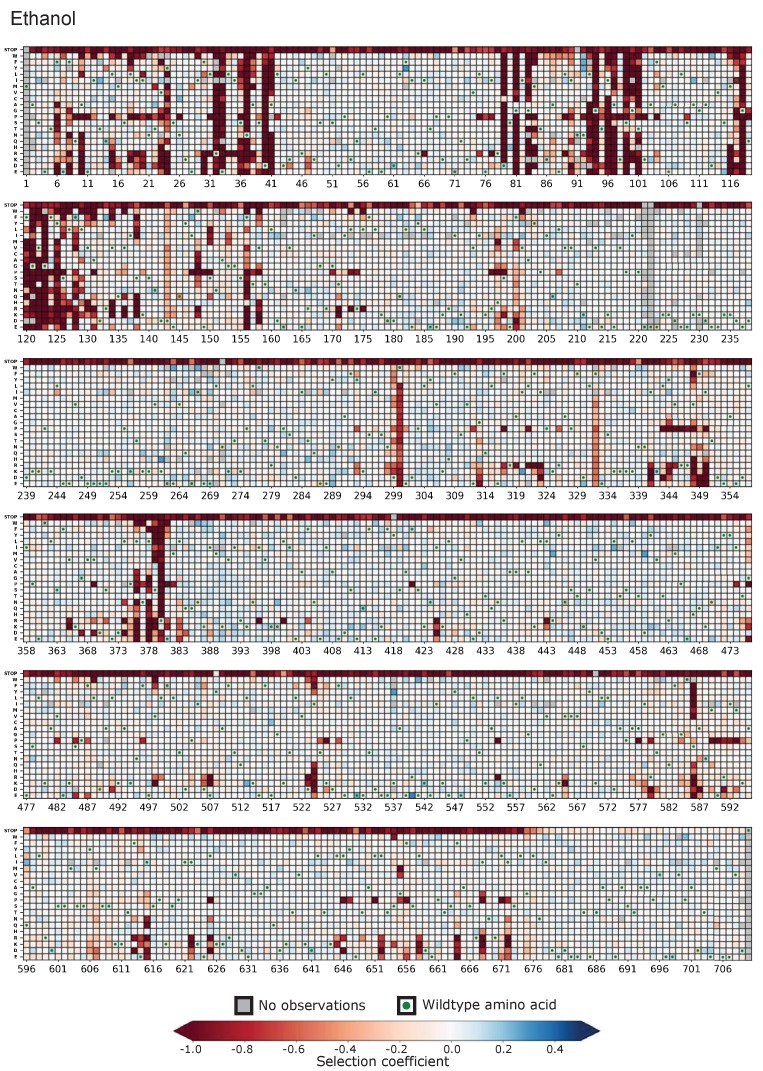
Heatmap representation of the fitness map observed for single amino acid changes of Hsp90 in ethanol.